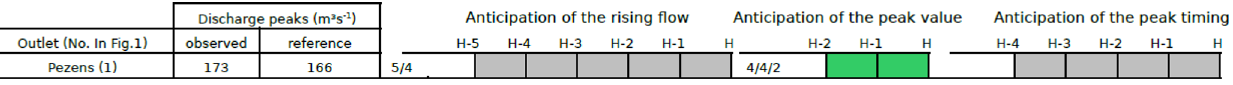
Figure 8. (a) Mean and (b) root mean square errors for AROME-NWC (in blue) and PIAF (in green) over their respective forecast ranges for 15min rain accumulation forecasts averaged over the catchments. Table 3. Best anticipation of the rise in flow, peak value and peak timing simulated with ISBA-TOP driven by the AROME-NWC rainfall forecast for the Fresquel river at Pezens on 14–15 October 2018. For more explanation on how to read the table, see Sect. 3.3.